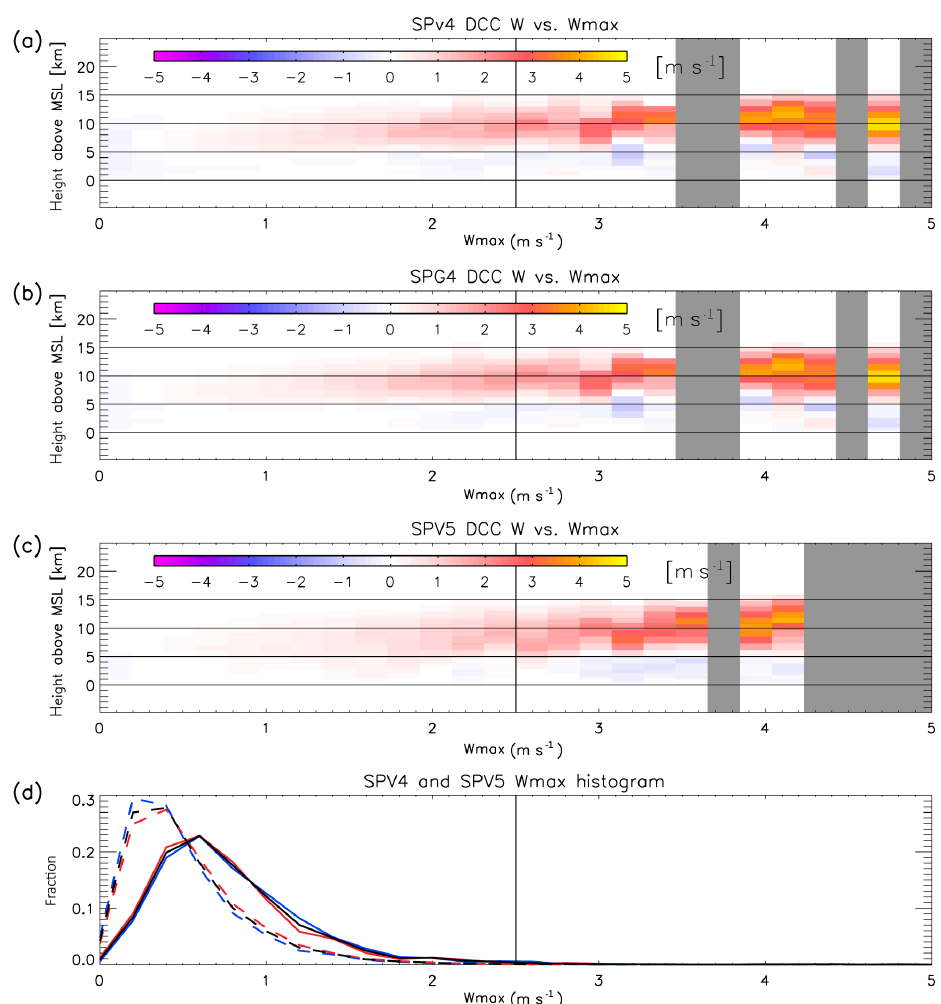
Figure 11. Same as Fig. 8, but for DCC vertical velocity profiles. Note that the results for SPV4 and SPG4 are